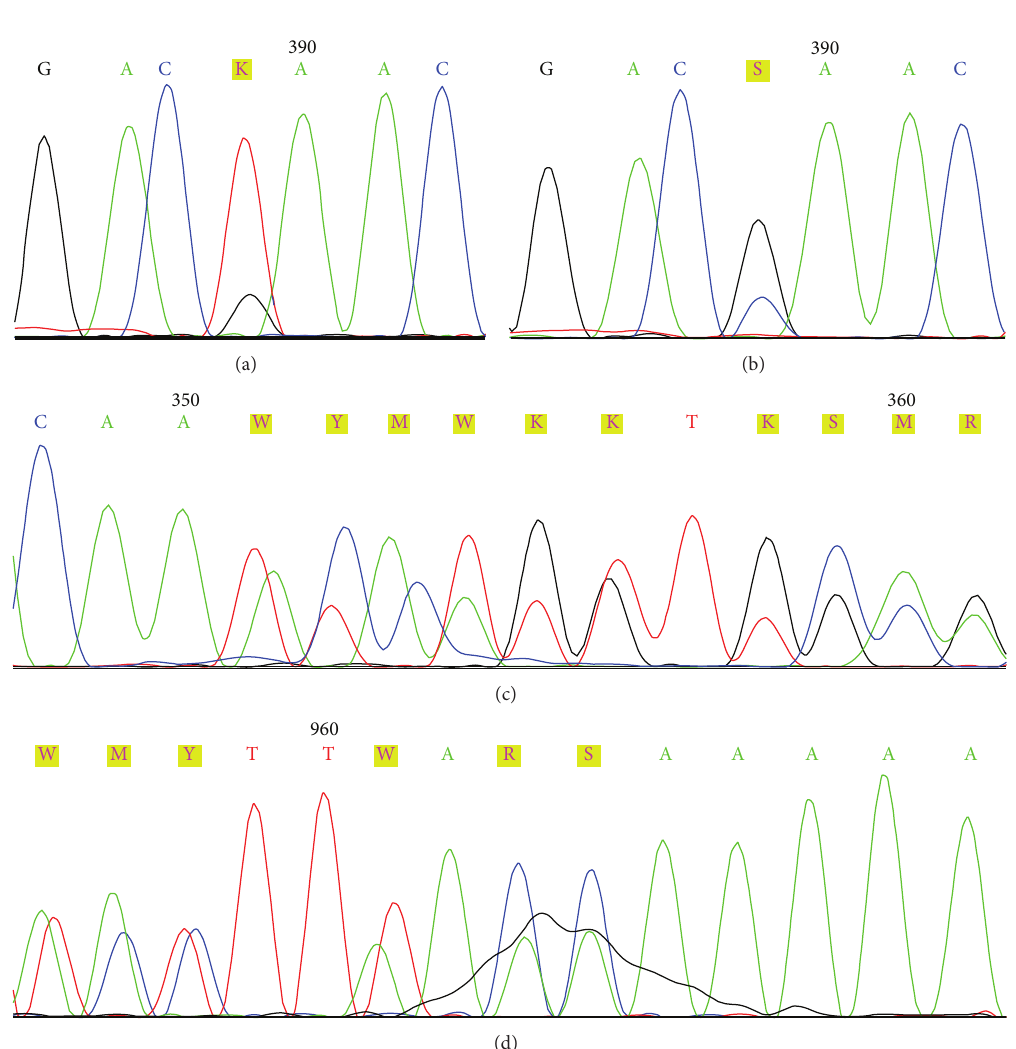
Figure 1: Spectrum of PTEN mutations in Slovak women.